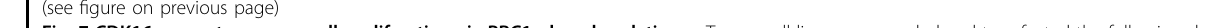
Fig. 7 CDK16 promotes cancer cell proliferation via PRC1 phosphorylation. a Tumor cell lines were seeded and transfected the following day with siRNA targeting PRC1 and/or CDK16 or with scrambled control. Cell viability was assessed by an MTT assay, and the columns represent the means ± SEMs of at least 3 independent experiments performed in triplicate. * P < 0.05 vs control, Mann – Whitney test. b Tumor cell lines were seeded and transfected the following day with siRNA targeting PRC1 and/or CDK16 or with scrambled control. After 3 days, the cells were detached and seeded in 6-well plates. The colony formation ability was assessed 2 weeks later. The columns represent the means ± SEMs of at least 3 independent experiments performed in duplicate. * P < 0.05 vs control, Mann – Whitney